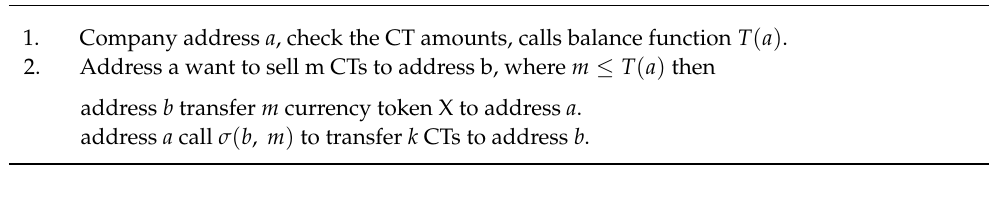
Algorithm 3 The processes and the operations of purchase account receivables